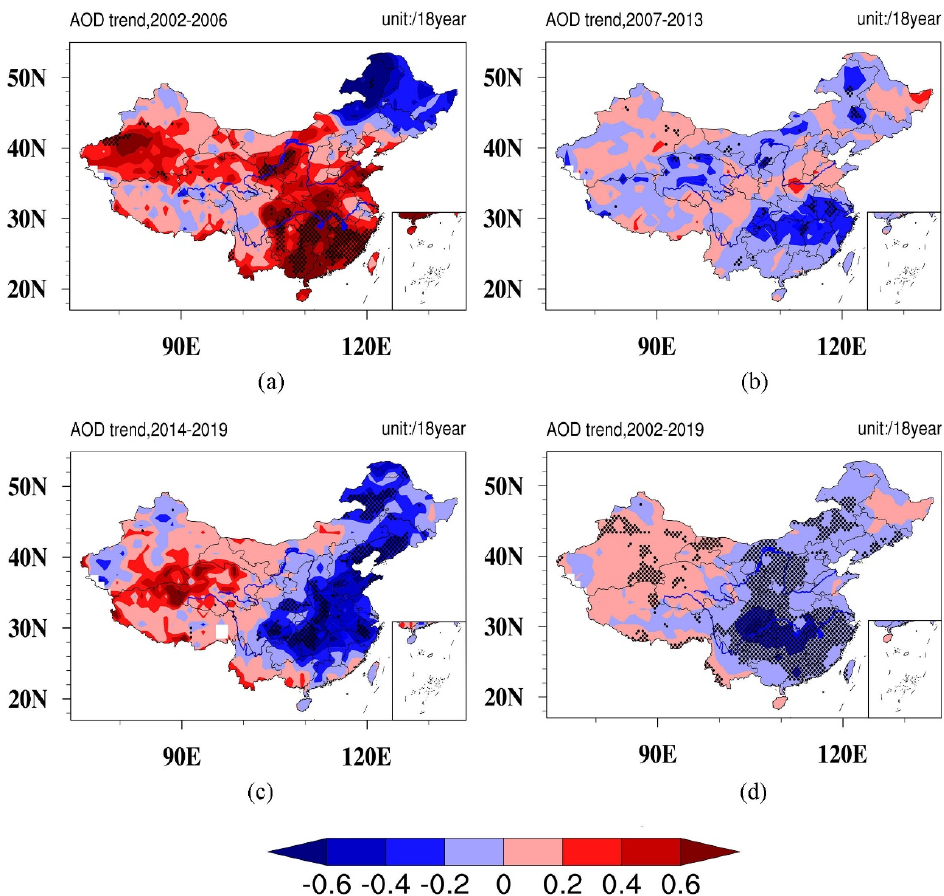
Figure 3. The trend of aerosol optical depth (AOD) over time periods of ( a ) 2002−2006, ( b ) 2007−2013, ( c ) 2014−2019, ( d ) 2002−2019. The dots indicate grids where that the linear trends are significant at the level of 0.05.